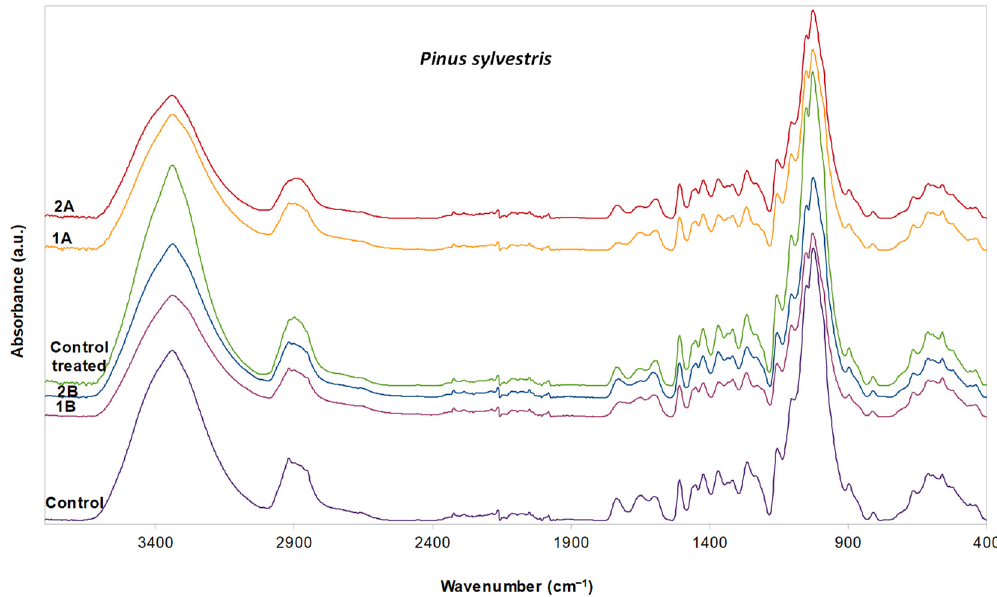
Figure 6. Spectral band assignments of the main spectral peaks observed in the Scots pine wood FTIR spectra. 1A—Fe 2 O 3 ; 2A—FeCl 3; 1B—Fe 2 O 3 + tannic acid; 2B—FeCl 3 + tannic acid.